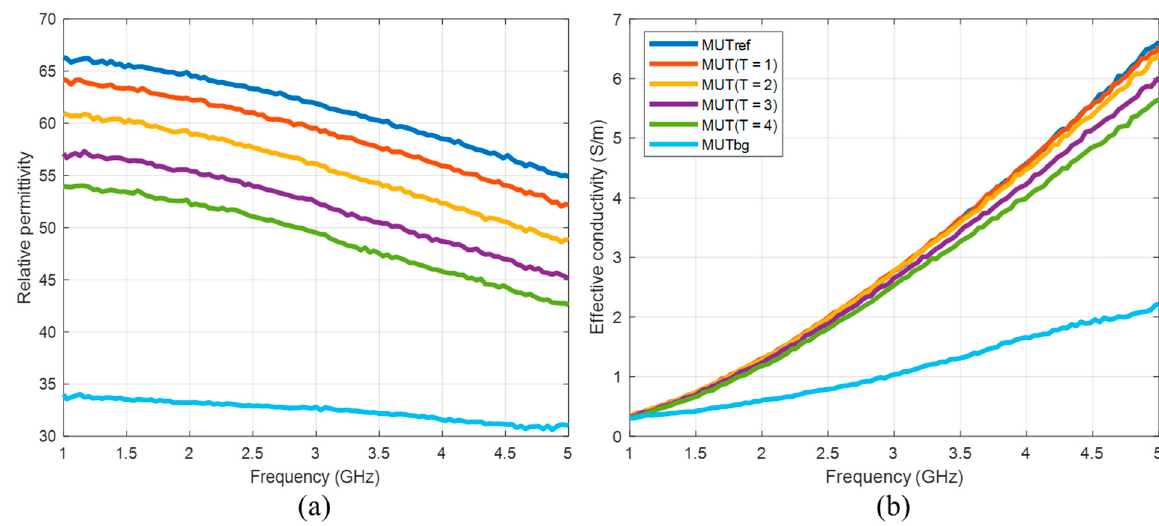
Figure 4. ( a ) Relative permittivity and ( b ) effective conductivity of MUTs as a function of frequency. Table 1. Materials under test used in the experiments.